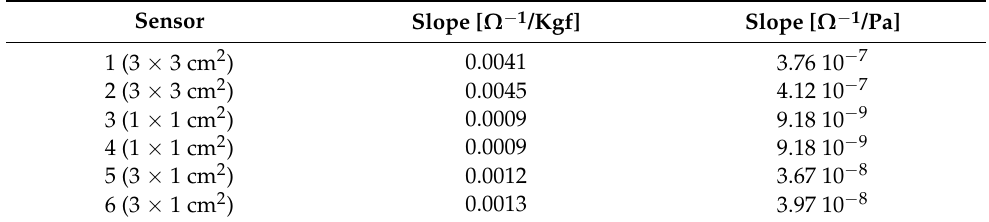
Table 5. Summarizing table with slopes of the reciprocal resistance trends for the six tested